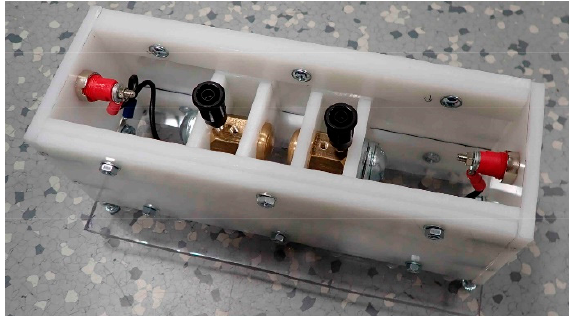
Figure 7. Adjustable sphere-sphere spark gap [45].